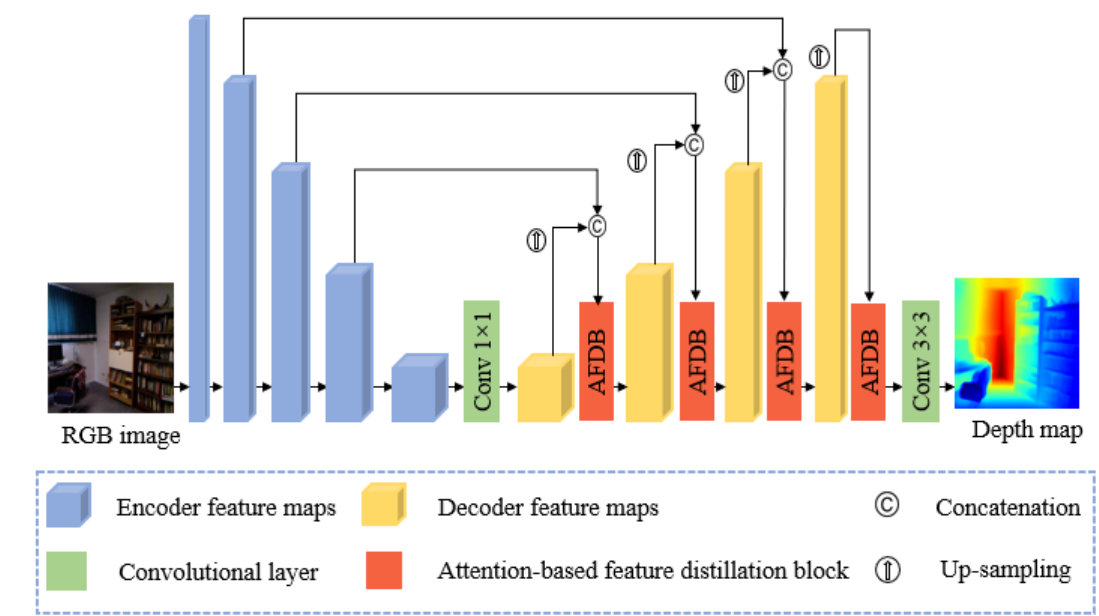
Figure 2. Proposed network architecture.